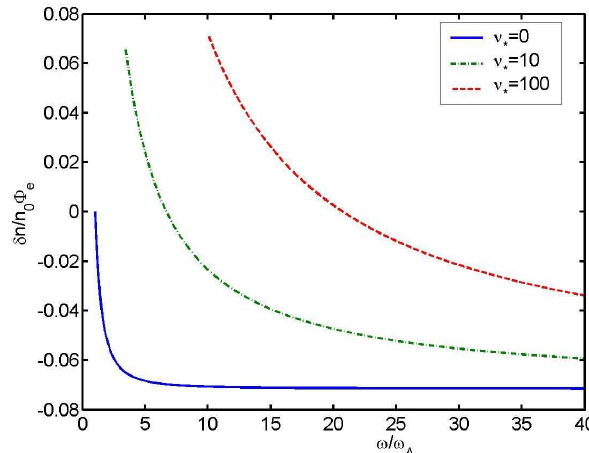
Fig. 5. The wave impedance as a function of the wave frequency. The parameters are the same as in Fig. 4.